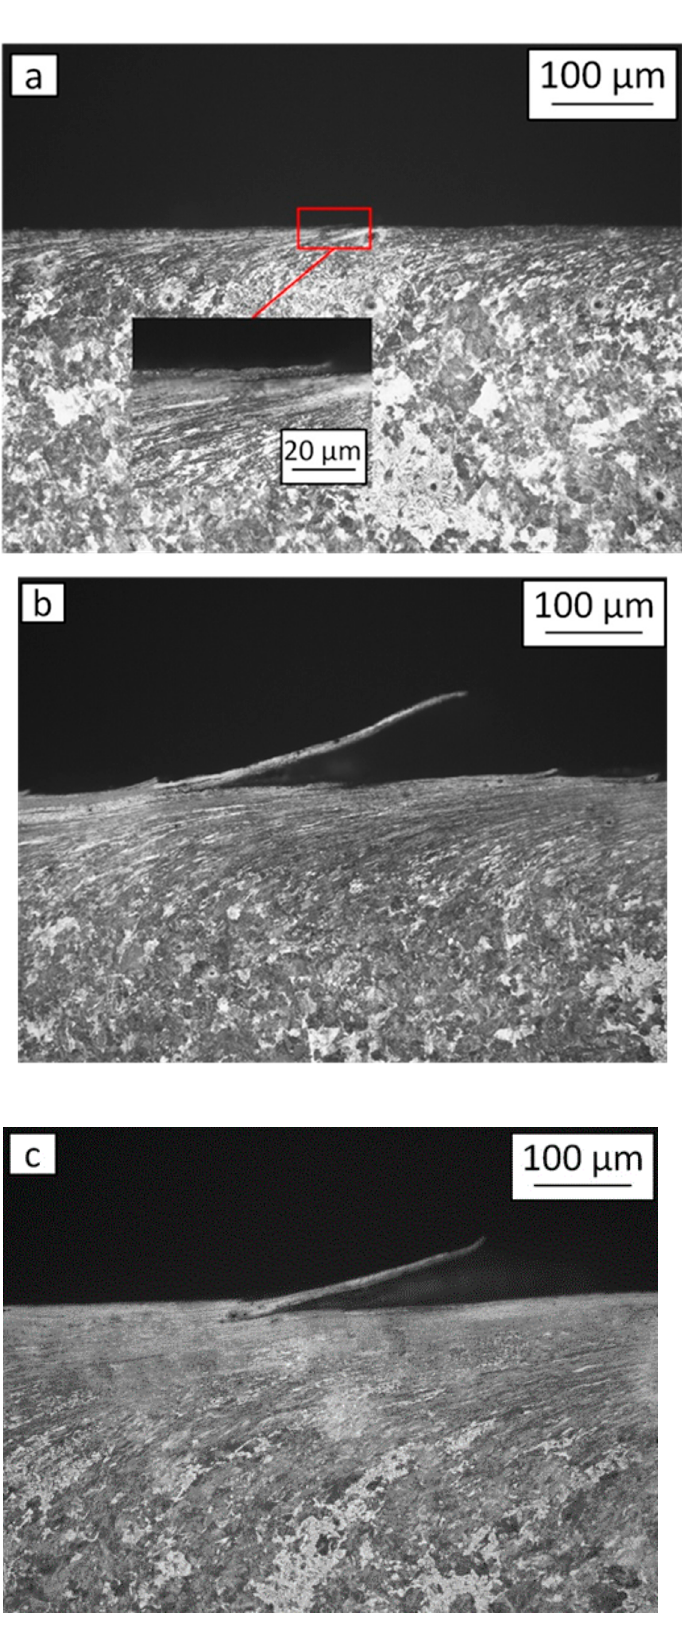
Figure 11. Cross-sections of the wheel discs at the end of the continuous validation tests: ( a ) V01 (10,000 cycles), ( b ) V02 (25,858 cycles), and ( c ) V03 (100,000 cycles).